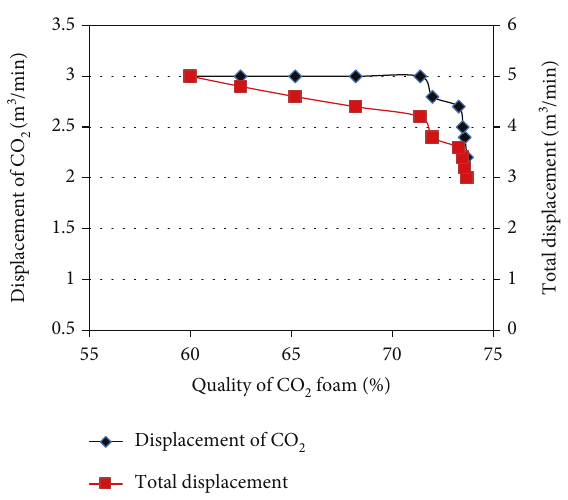
Figure 2: Pump rate and CO